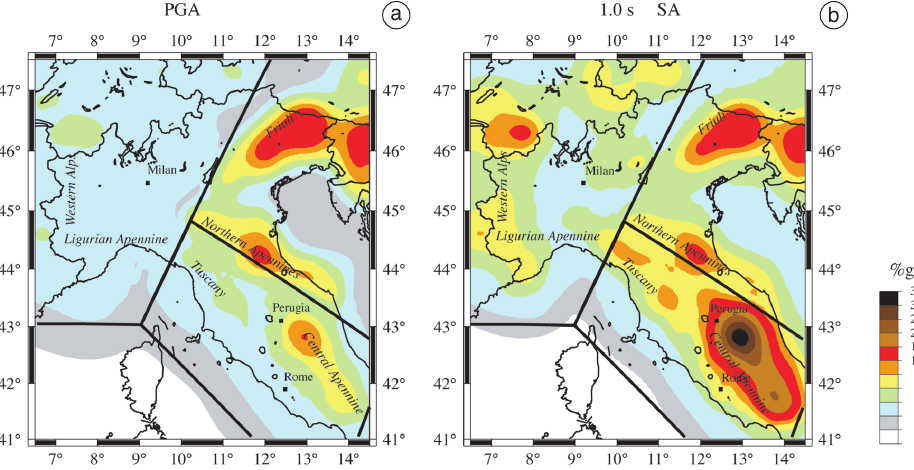
Fig. 9a,b. a) Overall PGA 95% confidence band map in Northern and Central Italy. b) Overall 1-Hz spectral ac- celeration 95% confidence band map in Northern and Central